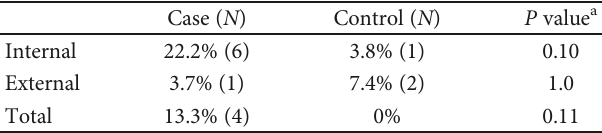
Scores are given as median (IQR) with higher scores denoting poorer Table 7: Percentage of XY DSD patients in clinical range on syndromic scores as compared to controls.